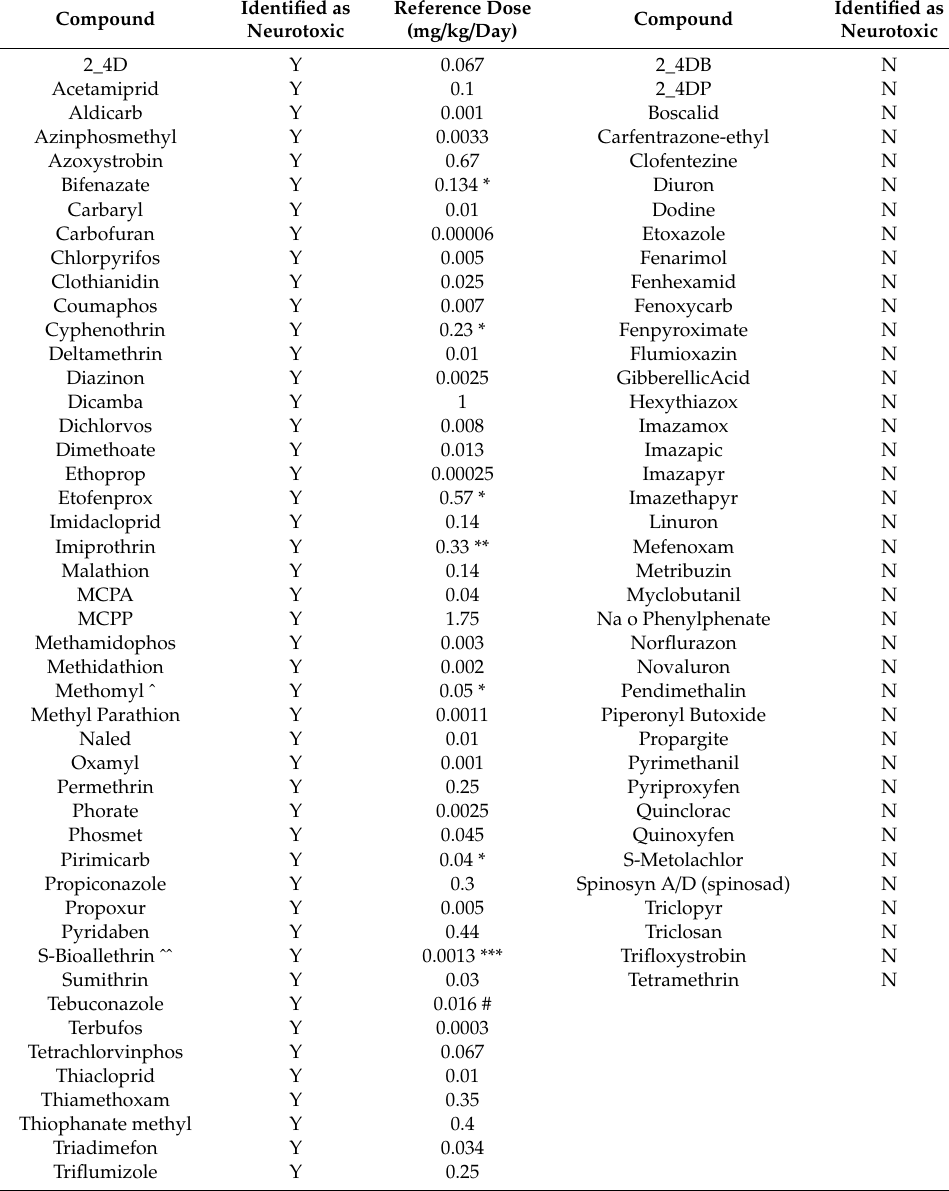
Table 1. Classification of pesticides detected in household dust. Pesticides were identified as potentially neurotoxic based on available health endpoint data in U.S. Environmental Protection Agency (EPA) Registration Eligibility Decisions (REDs), human health risk assessments, or other health assessment data available in (re)registration dockets. Table 1 identifies which pesticides were identified as potentially neurotoxic and provides a reference dose (RfD) for each.